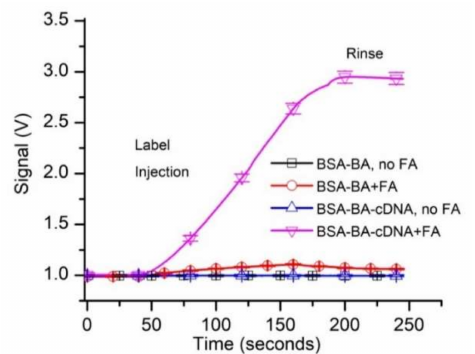
Figure 2. Preliminary testing of the fluorescent aptamer’s suitability for equilibrium and concentration measurements by kinetic exclusion assay. The tests investigated specific and non-specific binding of 50 pM fluorescent aptamer (FA) to control and capture beads. All the data in the graphs represent experimental values, with the symbols added for identification. Each curve shows the average values of experimental data (n = 3, ±